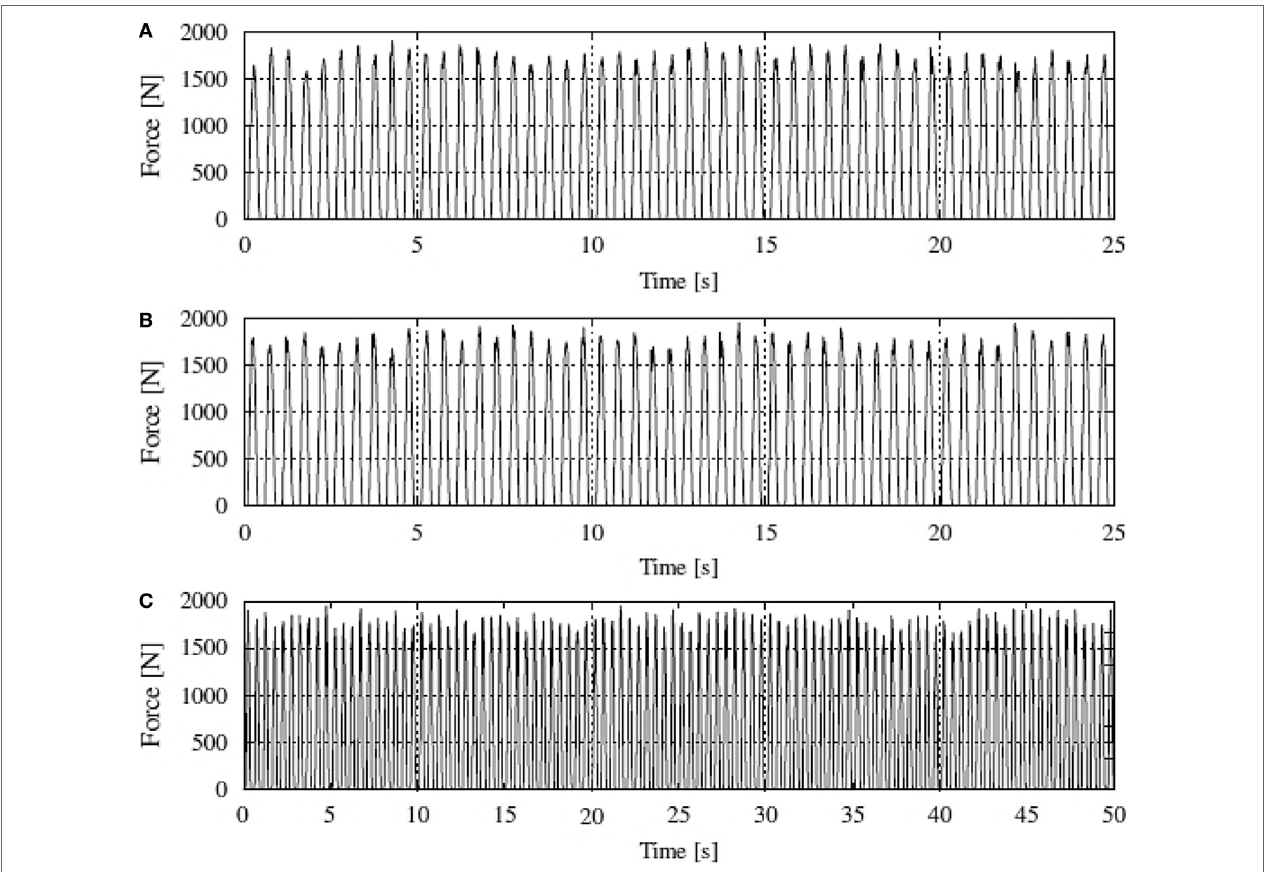
FiGURe 11 | (A) Measured and examples of synthetic force signals when (B) N = 50 and (C) N = 100. Jumping rate is 2 Hz. Reprinted from (Racic and Pavic, 2010b) with permission from